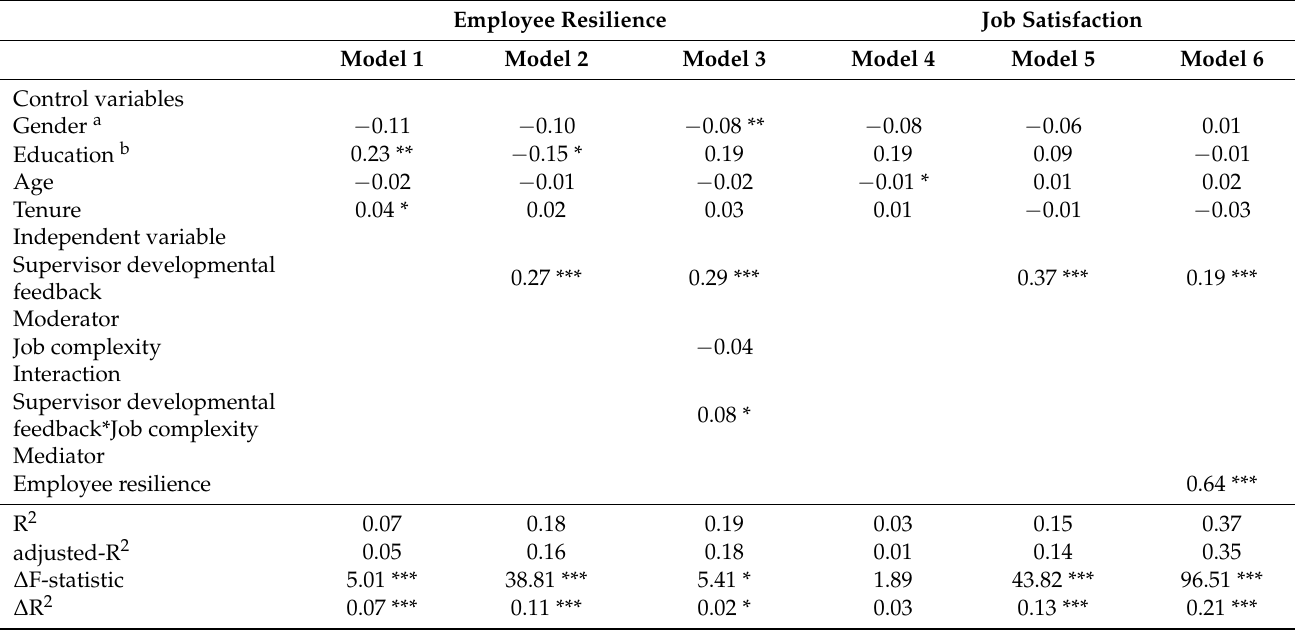
Table 4. Results of hierarchical regression